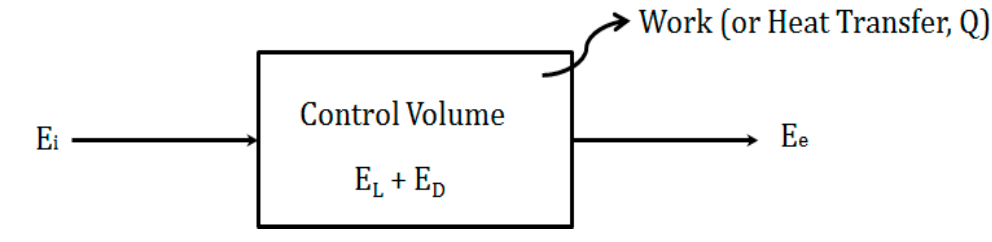
Figure 1. Exergy components in the change process.